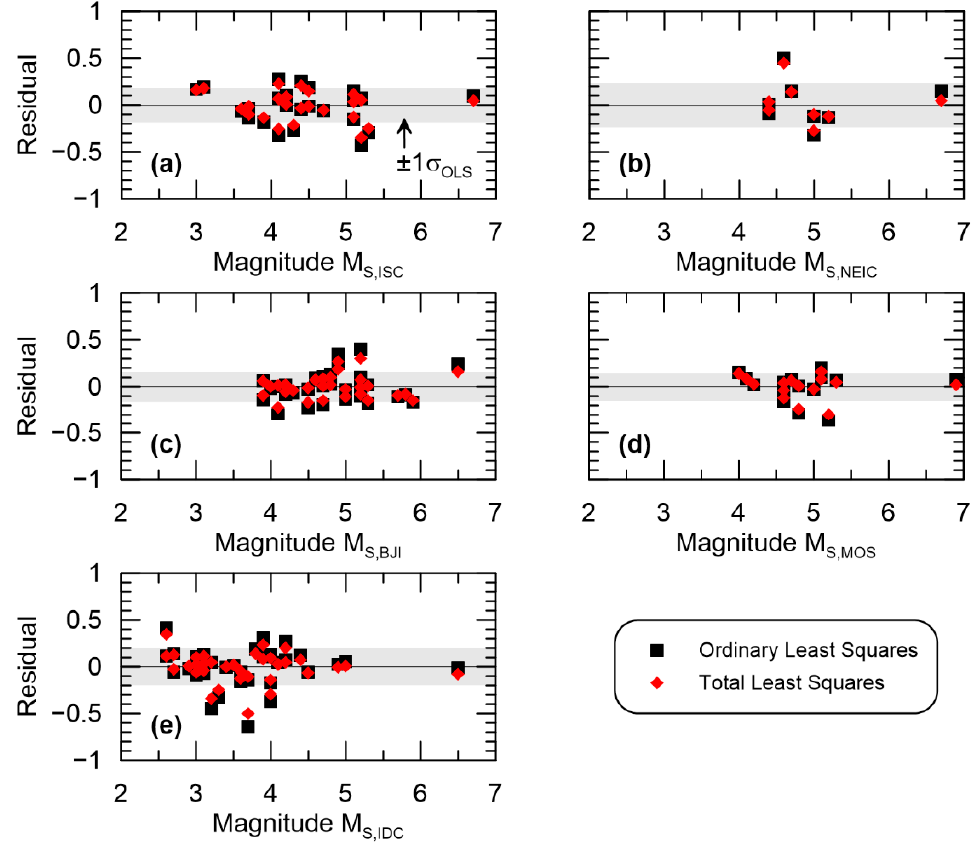
Figure 6. Regression residuals for M S from ( a ) ISC, ( b ) NEIC, ( c ) BJI, ( d ) MOS, and ( e ) IDC. The shaded regions represent ±1 σ from OLS regression.